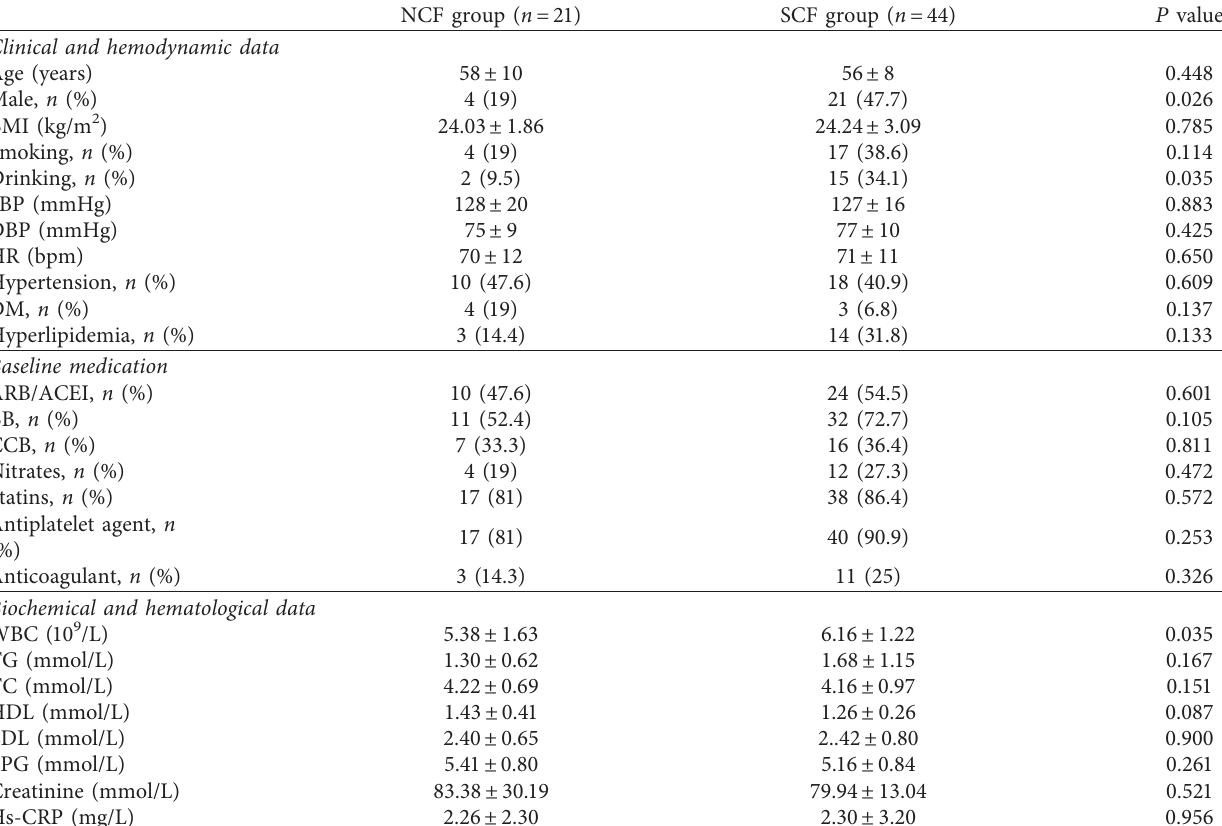
Table 1: Clinical characteristic of the study